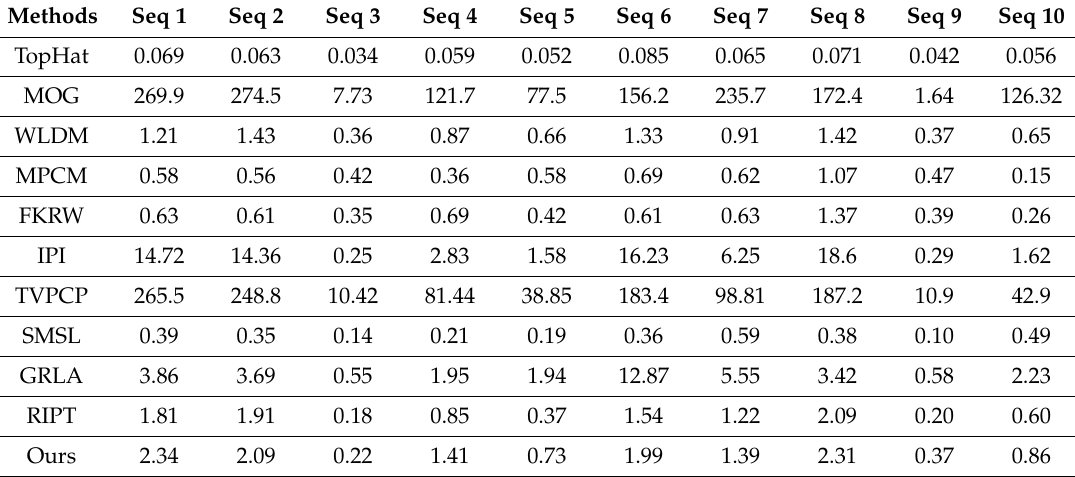
Table 6. The average execution time (frame / s) of di ff erent algorithms on 10 real sequences.